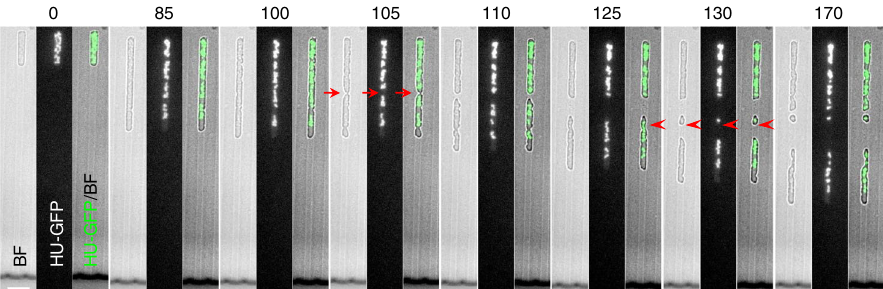
Fig. 4 Bisection of chromosomes occurs occasionally in L -forms. A small cell with little DNA (arrowheads in Frame 130 min) appeared to be not growing, possibly because its chromosome is incomplete. These are selected still frames from Supplementarty Movie 7. The cell shown was in a 1.8 µ m wide channel (Chip No. 7). Arrows point to division between nucleoids; arrowheads point to possible division through nucleoids. Scale bar, 5 µ m. Similar events could be observed occasionally at different locations from independent experiments (repeated at